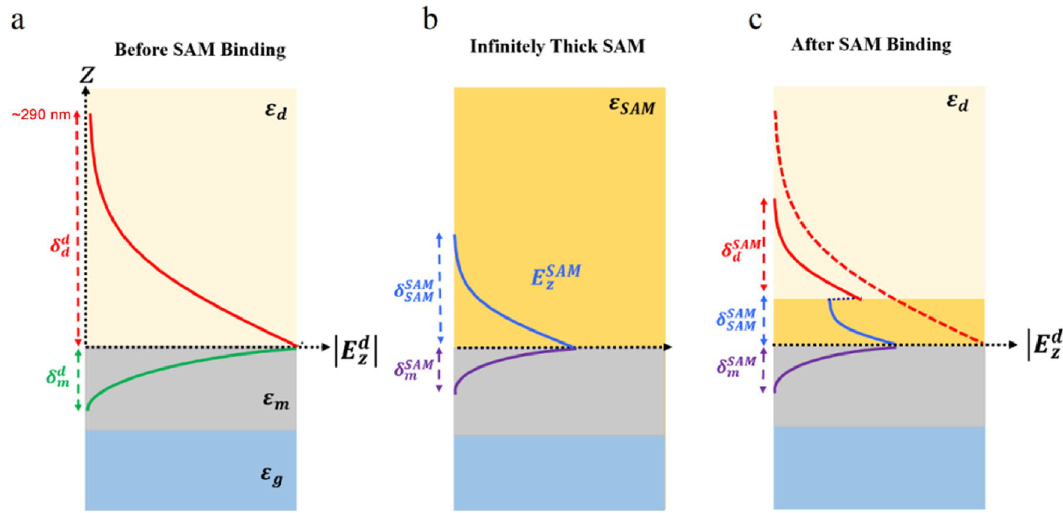
Figure 4. Schematic of the decay of the E z component associated with the SPP EM field for ( a ) free-space propagation, ( b ) in a quasi-infinitely thick SAM and ( c ) in a single SAM just one molecule thick. The dotted arrows denote the extent of the field in metal ( δ thickness of the metal layer is ~ 150